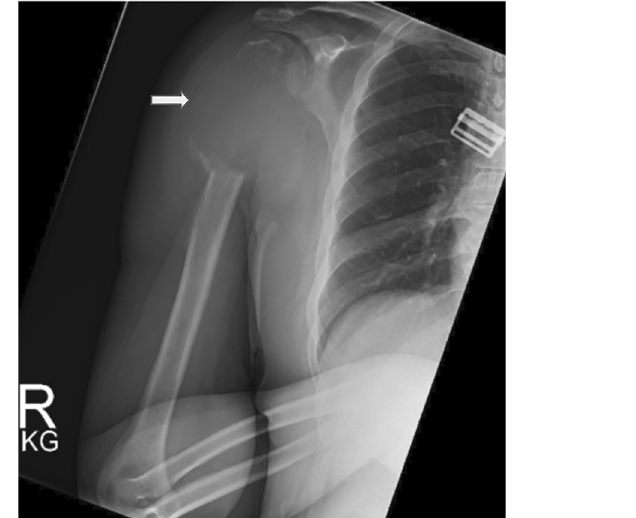
Image 2. Right humerus radiograph demonstrates an area of presumed soft-tissue mass causing bony destruction of the right proximal humerus (arrow) three months later.